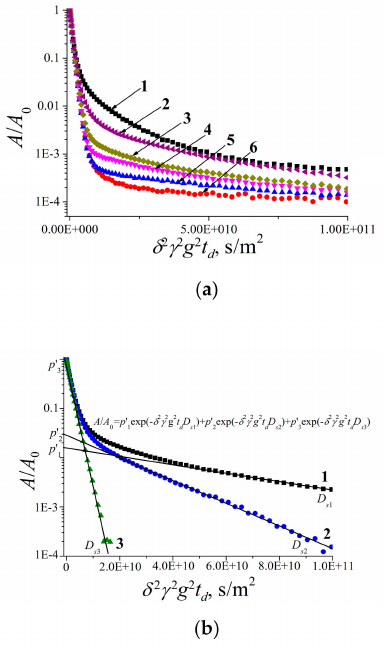
Figure 60. ( a ) The diffusion decays of water molecules in RBCs measured at various t d (1—10 ms,